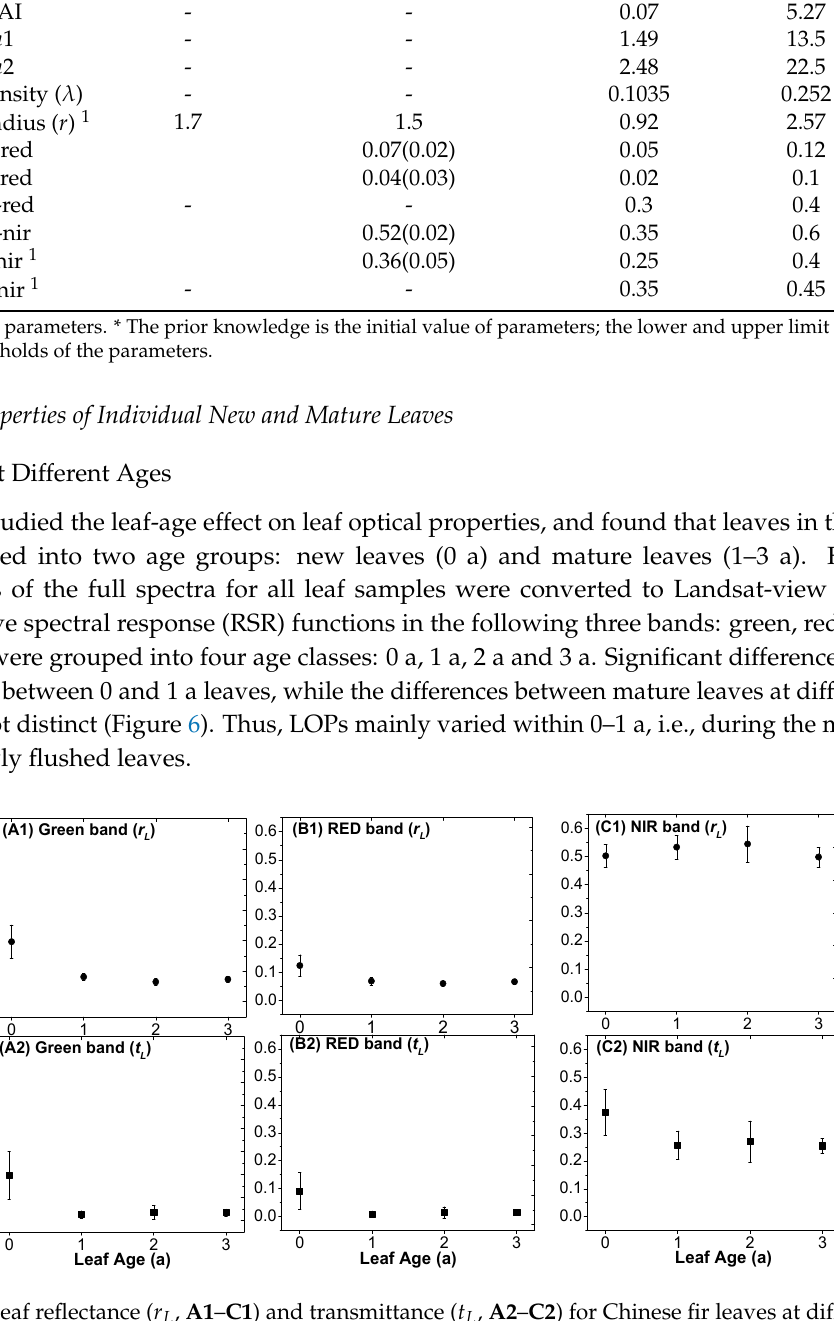
(cid:1870) (cid:3013) -red